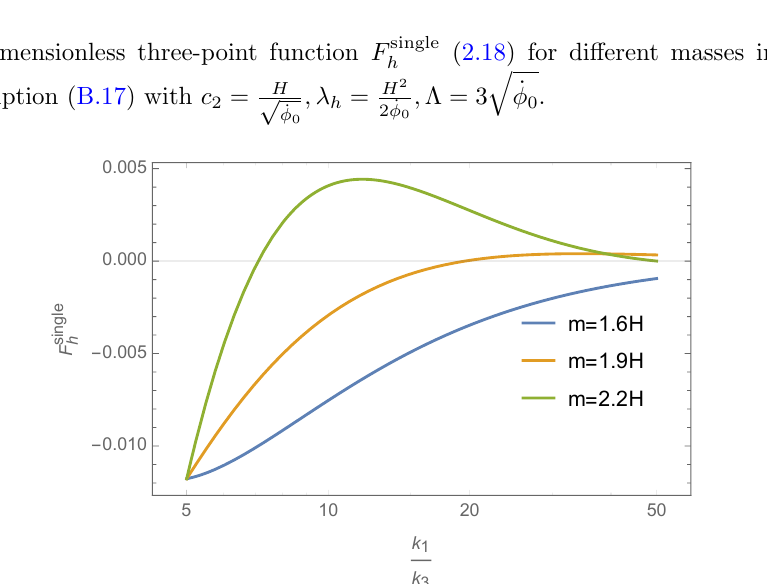
Figure 7 . Dimensionless three-point function F single Slow-roll description (B.17) with c 2 = H p